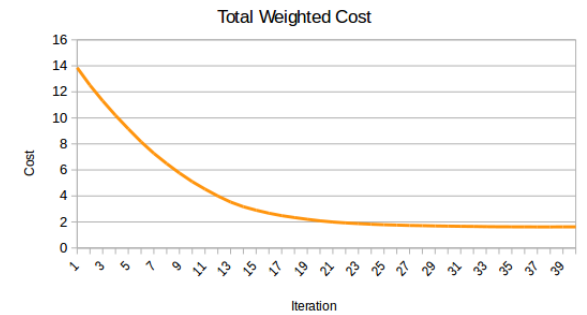
Figure 1: Relative cost at every iteration expressed as a percentage of the initial cost. F is shown in blue and G is shown in red.